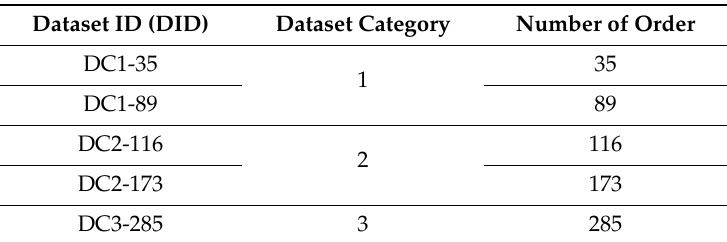
Table 5. Datasets for experiment.